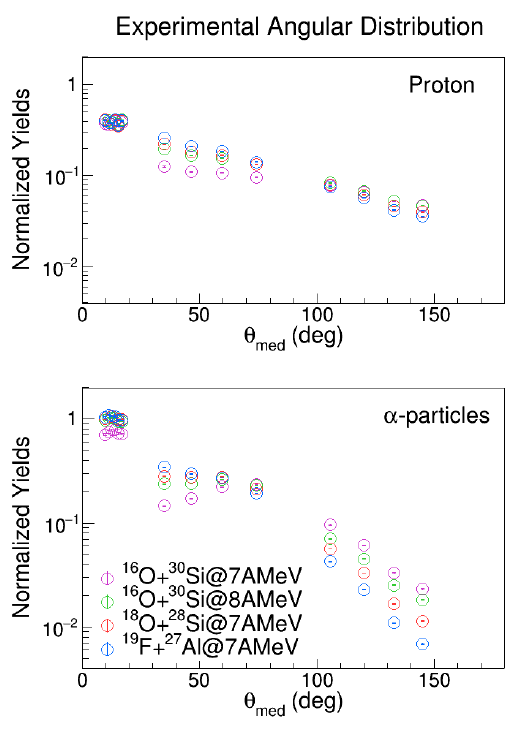
Table 1. Summary of the main characteristics of the studied reactions. Fig. 1. Experimental angular distribution of protons (upper panel) and  -particles (lower panel) for the four studied reactions. The distributions are normalized to the number of complete events. The error bars are inside the experimental